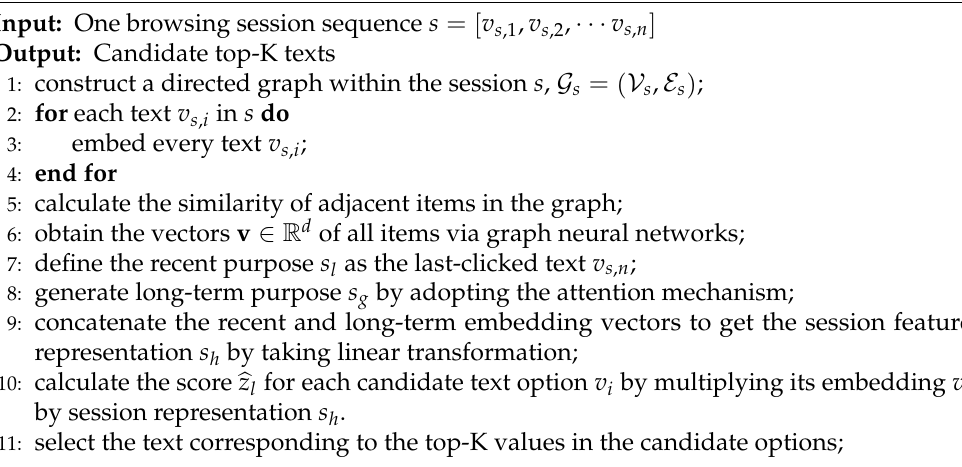
Algorithm 1 Pseudocode of the TXT-SR